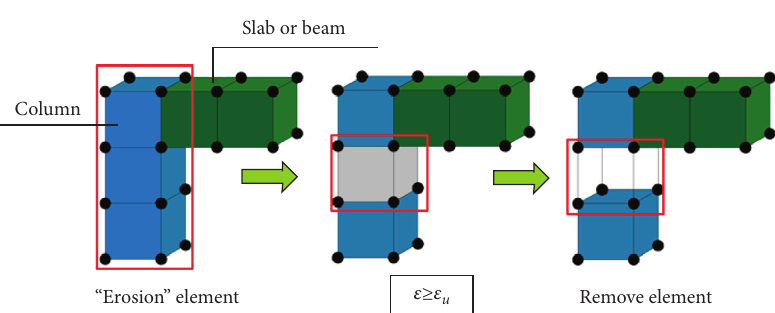
Figure 7: Schematic diagram of column (beam) element deletion technology.